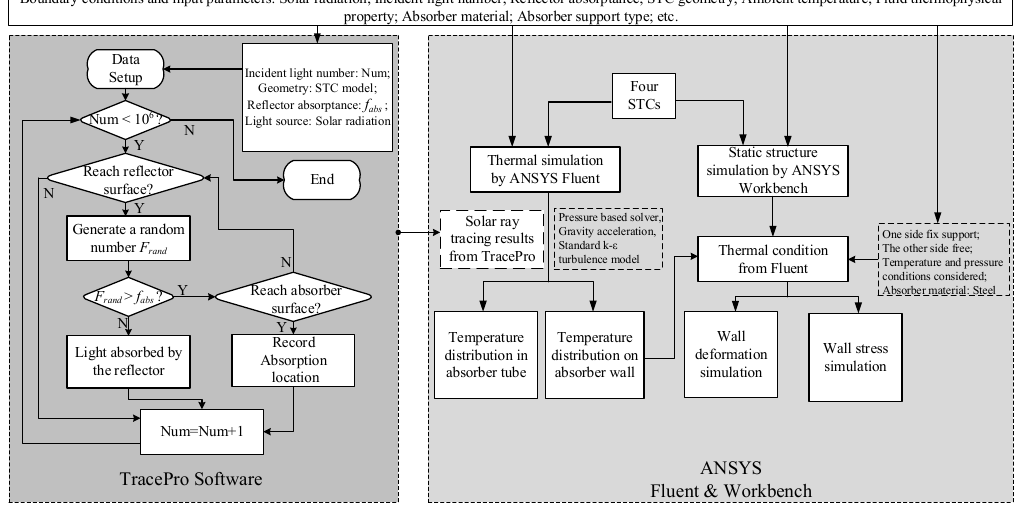
Figure 5. Simulation methods in this study.